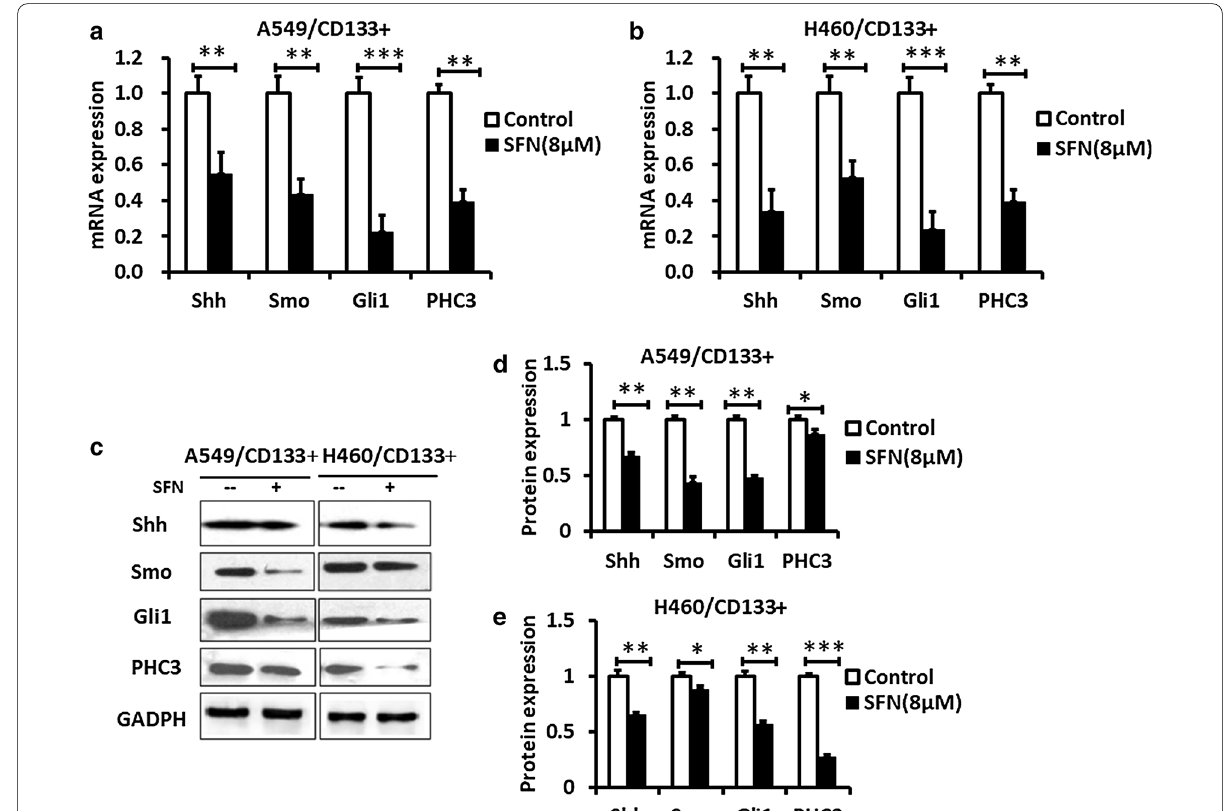
Fig. 3 SFN inhibits expression of Shh, Gli1, Smo and PHC3 in human lung CSCs. a , b QPCR data shows that the mRNA levels of Shh, Gli1, SMO and PHC3 were significantly inhibited when lung CSCs were treated with SFN, compared with the control group. c – e Western blotting data shows that the protein levels of Shh, Gli1, SMO and PHC3 were significantly inhibited when lung CSCs were treated with SFN, compared with the control group. N 3, Data are presented as mean SD, *P < 0.05, **P < 0.01, ***P < = ±